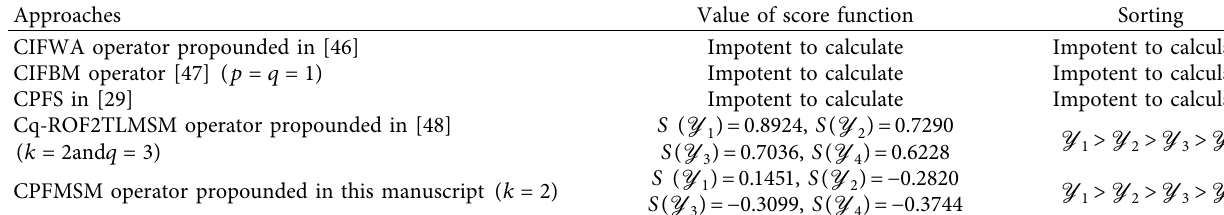
Table 11: Values of the score function and ranking of alternatives of Example 2.